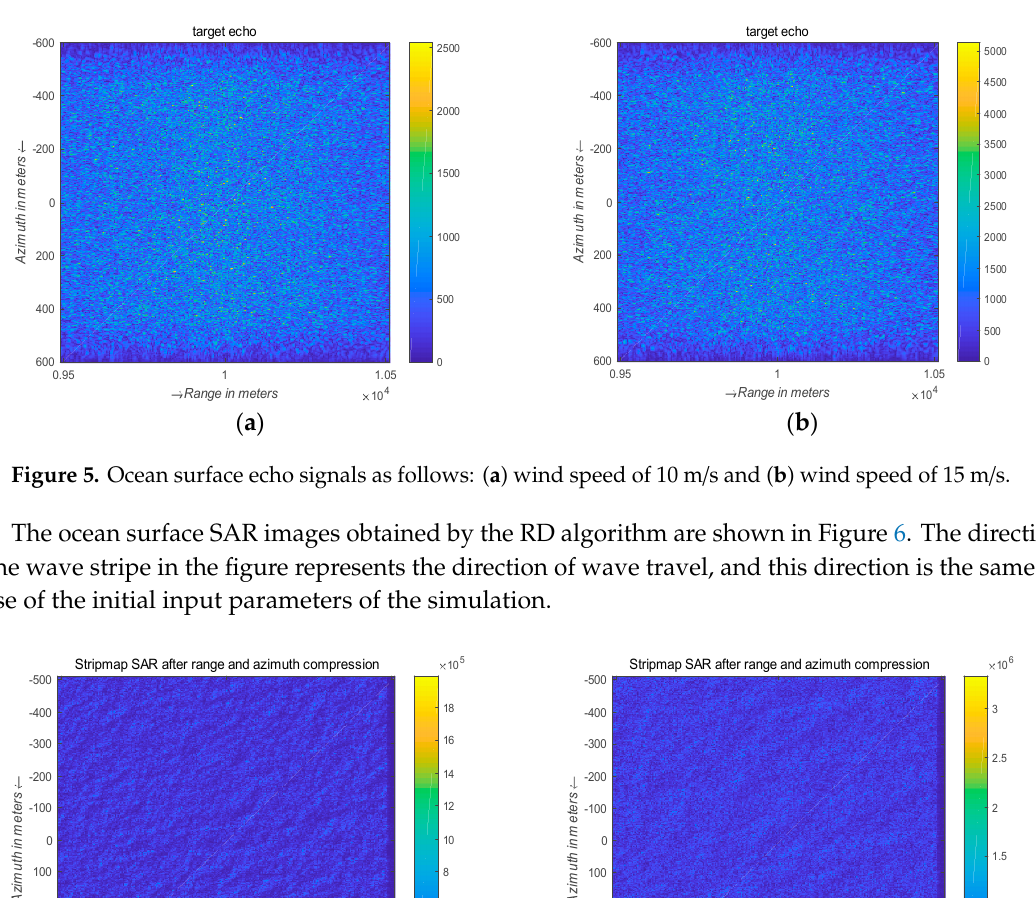
Table 1. System parameters.